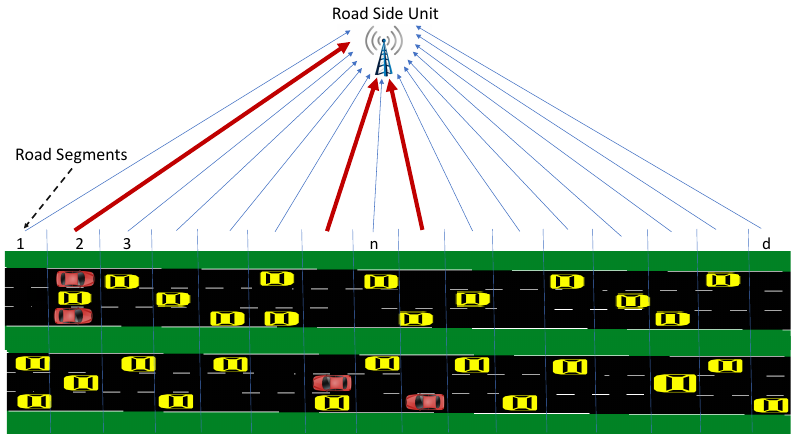
Figure 3. DDoS attack model where red cars are attackers and thick red lines denote the increased data rates.